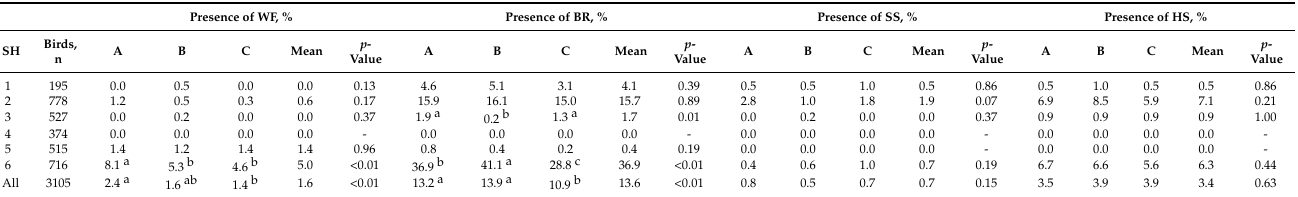
Table 7. Percentage of the outcomes of the animal-based indicators for the state of consciousness in